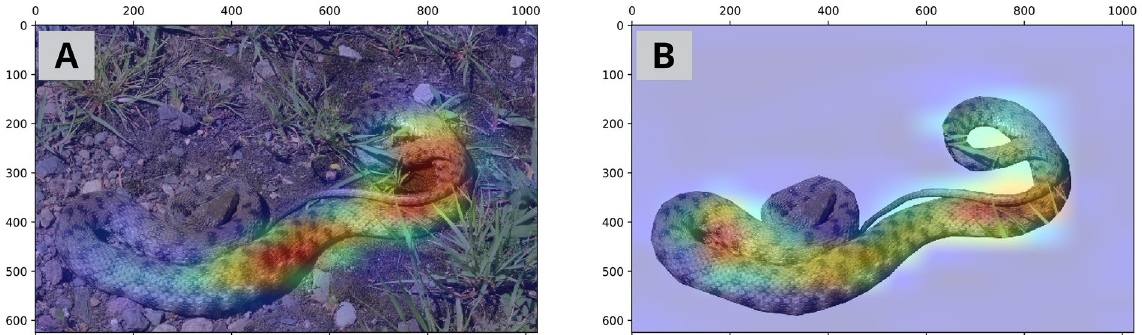
Figure 8. The heatmap visualization of the discriminative regions within the last activation layers of VGG-16 model, in Natrix ( A : correspond to N1 in Fig. 7) snake, after removing the natural substrates ( B